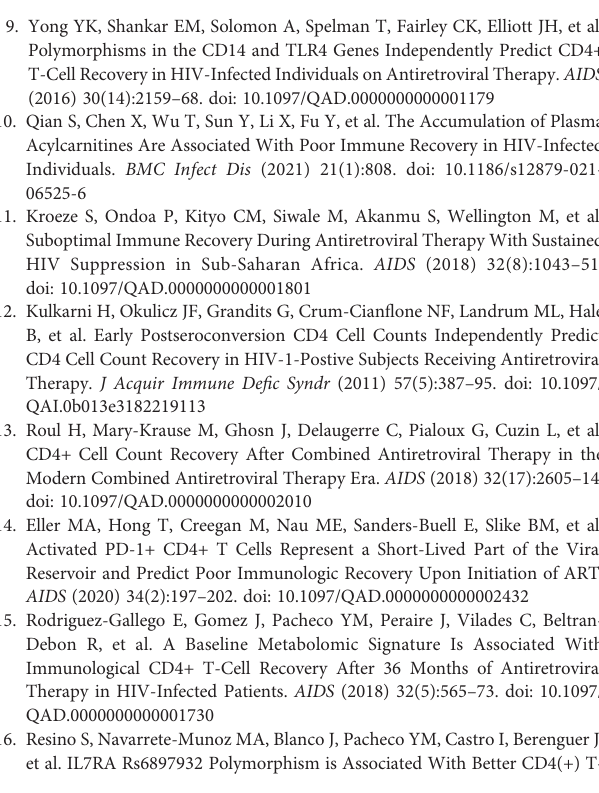
Supplementary Figure 1 | Relative expression of fi ve plasma microRNAs (miRNAs) in the training set. Relative expression of fi ve miRNAs in immune non- responders (INRs, n = 41) and immune responders (IRs, n = 85) in the training set. Supplementary Figure 2 | KEGG analysis by DIANA-miRPath v3.0. Heatmaps of signaling-pathway enrichment of fi ve miRNAs (A) and miR-16-5p (B) using the KEGG database by Tarbase and microT-CDS. Supplementary Figure 3 | Ef fi cacy of miR-16-5p overexpression in primary T cells. T cells from people with human immunode fi ciency virus (HIV) infection (n = 7) after antiretroviral therapy (ART) were transfected with miR-16-5p mimic or control (10nM). The ef fi cacy of miR-16-5p overexpression was con fi rmed by RT-qPCR. Data are presented as the mean ± SD. Supplementary Figure 4 | Overexpression of miR-16-5p does not affect T cell apoptosis. T cells from people with human immunode fi ciency virus (HIV) infection (n = 9) after antiretroviral therapy (ART) were transfected with miR-16-5p mimic or control. Representative fl ow-cytometry data (A) and histogram (B) showing apoptosis of CD4 + T cells (top) and CD8 + T cells (bottom) measured using Annexin V and 7-Aminoactinomycin D. Supplementary Figure 5 | Matrix metalloproteinase-9 (MMP-9) decreased in the miR-16-5p overexpressed Jurkat cells. Relative quantitation of MMP-9 expression at protein level between miR-16-5p overexpressed (miR-16-5p mimic) and control Jurkat cells (n = 3). Label-free quanti fi cation (LFQ) intensity in different samples was centralized to obtain the relative quantitation value of